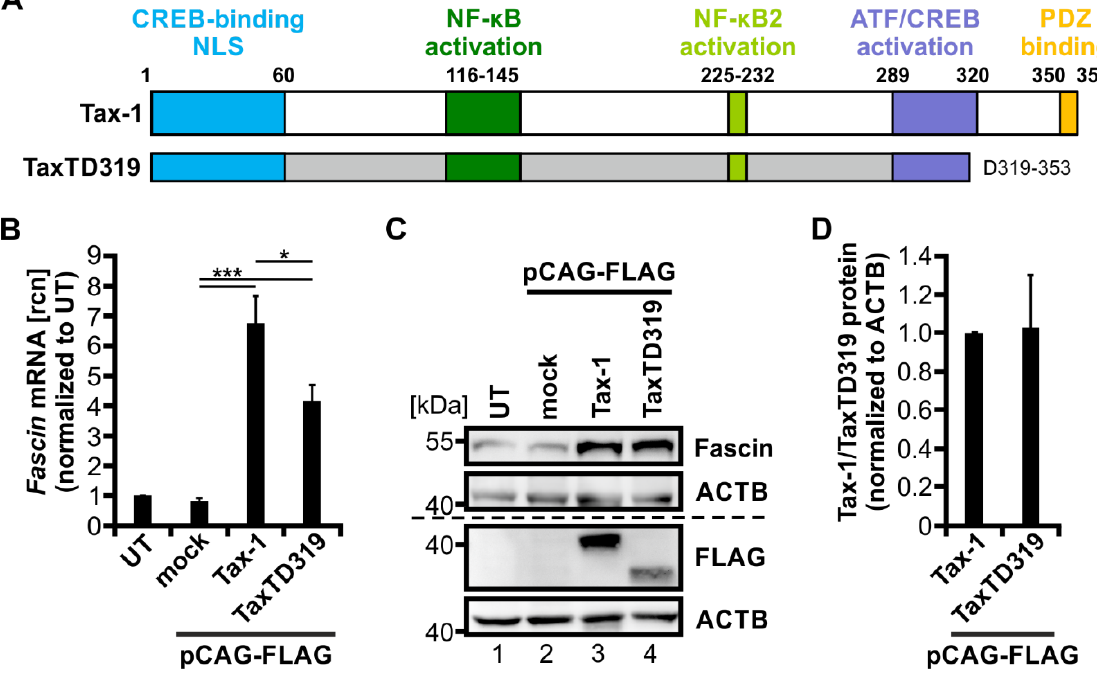
Figure 4. The PDZ binding motif of Tax-1 is necessary for full transcriptional induction of Fascin . ( A ) Scheme of Tax-1 wildtype (wt) protein (amino acid (aa) 1-353) and TaxTD319 deletion mutant (aa 1-319). Protein domains of Tax-1 are indicated: a cAMP response element-binding protein (CREB)-binding motif (aa 1-60) harboring a nuclear localization sequence (NLS), an NF- κ B activation domain (aa 116-145), an NF- κ B2 activation domain (aa 225-232), an activating transcription factor (ATF)/CREB activation domain (aa 289-320), and a PDZ binding motif (aa 350-353). ( B , C ) Jurkat T-cells were transfected with FLAG-tagged constructs for Tax-1, the deletion mutant TaxTD319, or the mock control vector pCAG-FLAG (50 µ g), or were left untreated (UT). ( B ) After 48 h, Fascin transcript levels were measured by quantitative PCR (qPCR) and normalized to those of β -actin . Relative copy numbers (rcn) were normalized to UT, and the means of four independent experiments ± SE were compared using Student’s t test (* p < 0.05, *** p < 0.001). ( C ) Representative immunoblot of Fascin, Tax (detected by FLAG antibodies), and β -actin (ACTB). ( D ) Densitometric analysis of FLAG-labeled protein normalized to ACTB and Tax-1 wt. Mean values of three independent experiments ± SE were compared using Student’s t